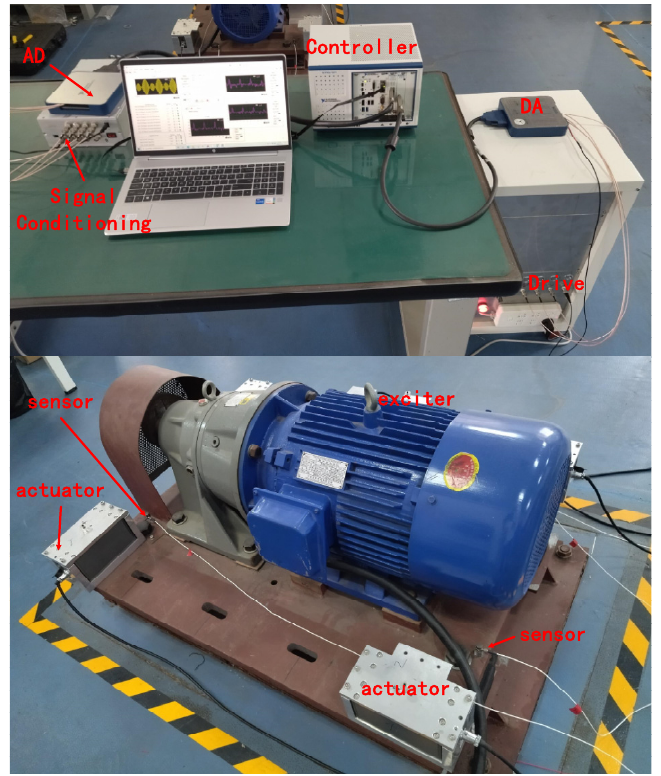
Figure 12. Vibration system and control system.